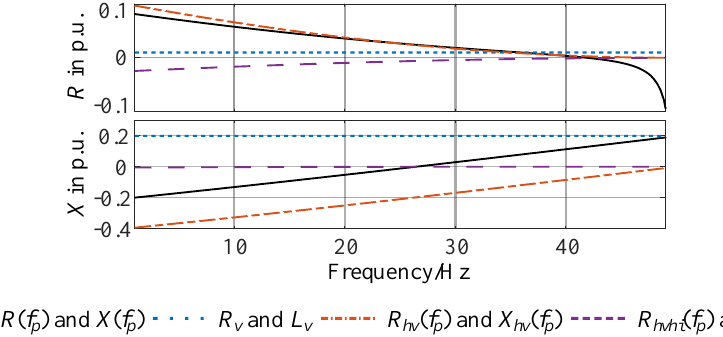
Figure 6. Equivalent resistance and reactance in p.u. of VSG controlled converters with cascaded inner control loop.